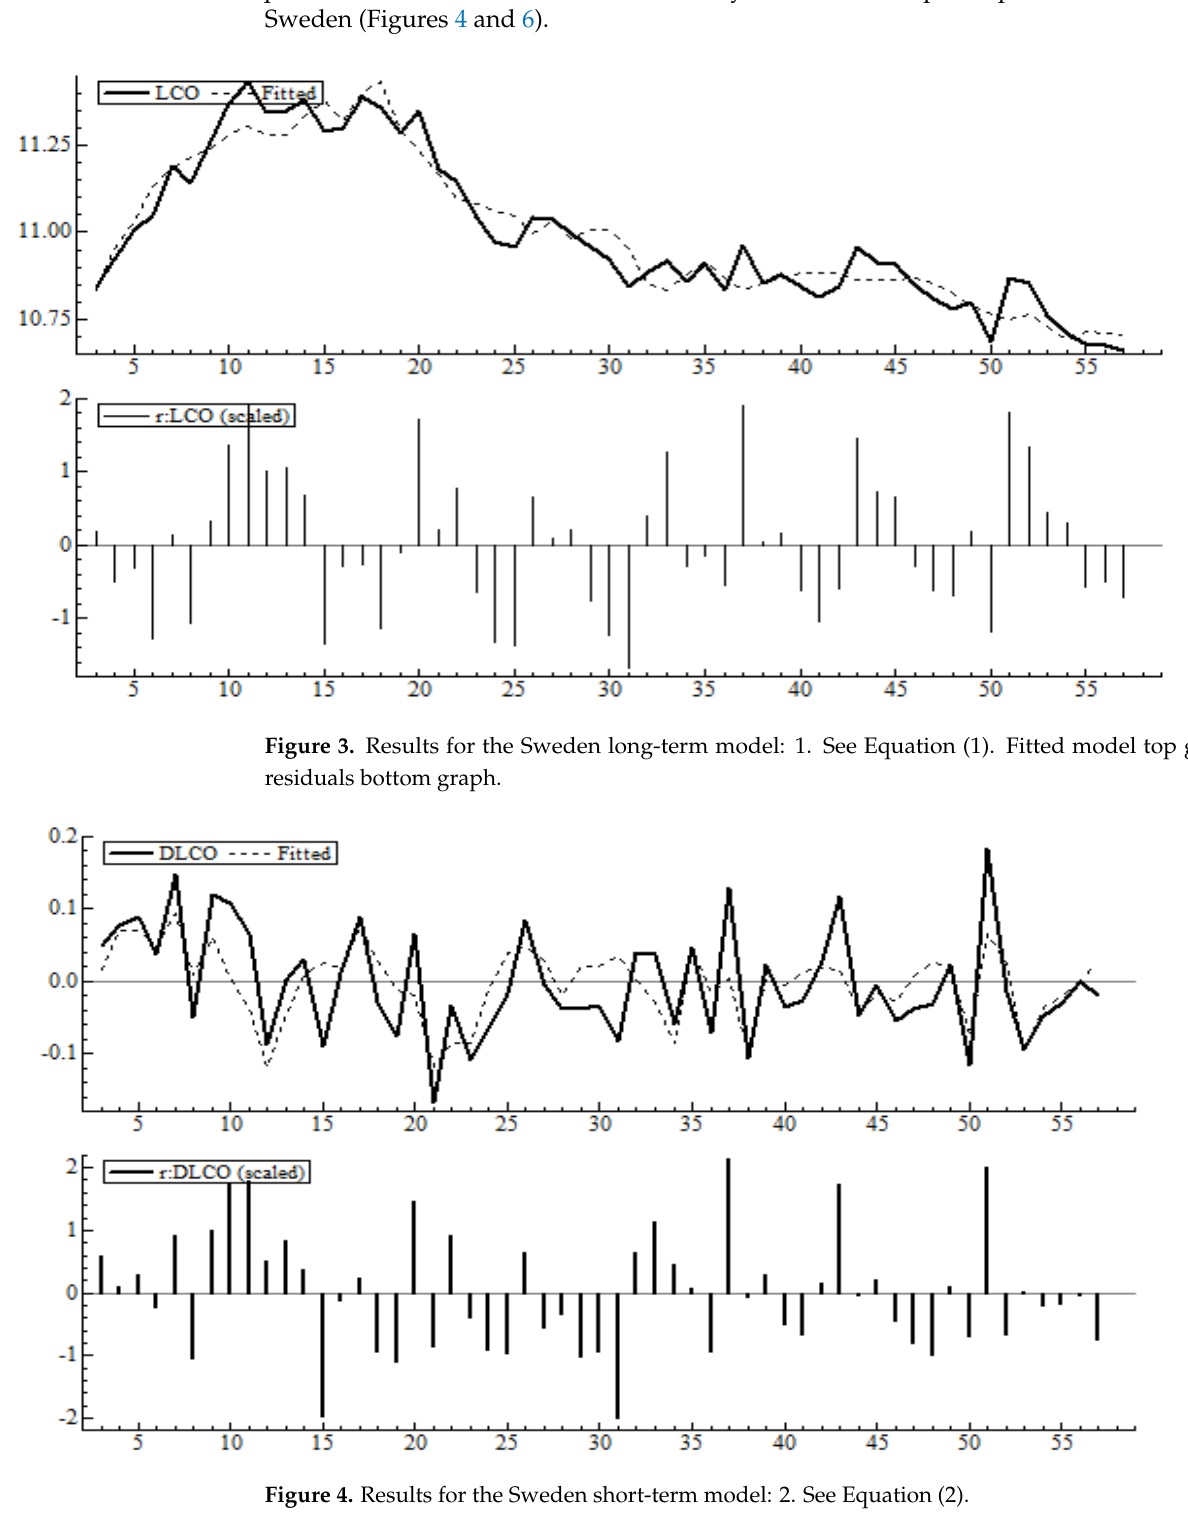
Figure 4. Results for the Sweden short-term model: 2. See Equation (2) .